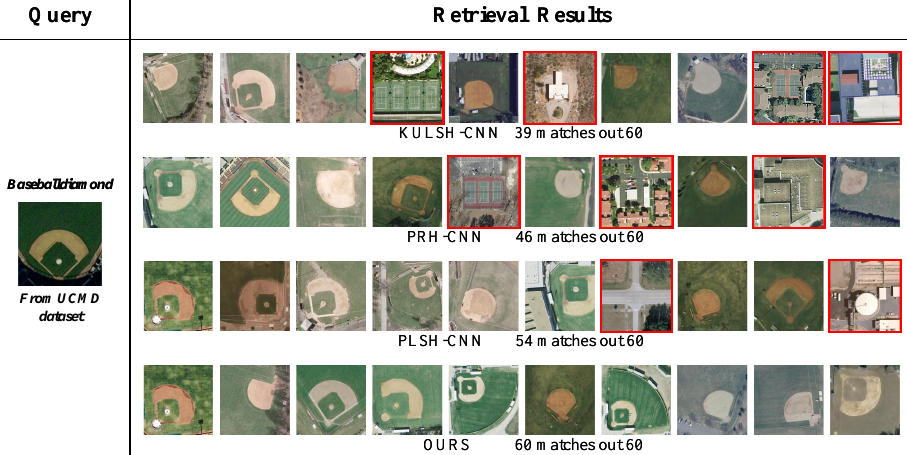
Figure 12. Retrieval results of “baseballdiamond” in the UCMD dataset by different competitive baseline methods. The single image in the left column is the query sample. Each row in the rest of the columns is the top-10 retrieval results from each comparable method. The results with red rectangles are incorrect, and the number of true positive results out of the top-60 retrieved images is also